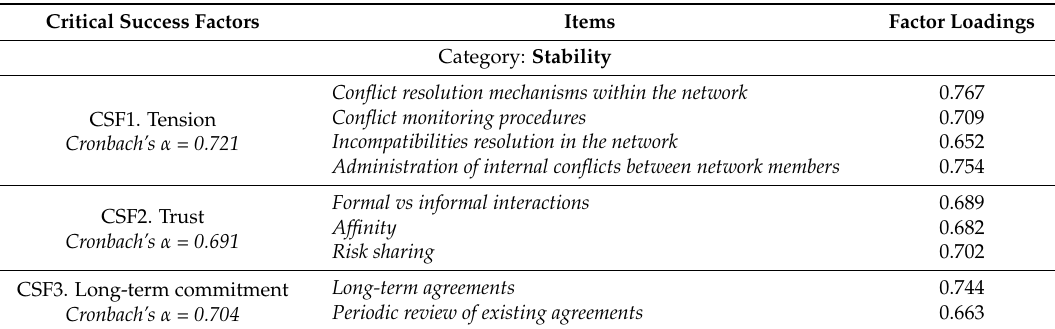
Table 4. Scale validation for coopetition